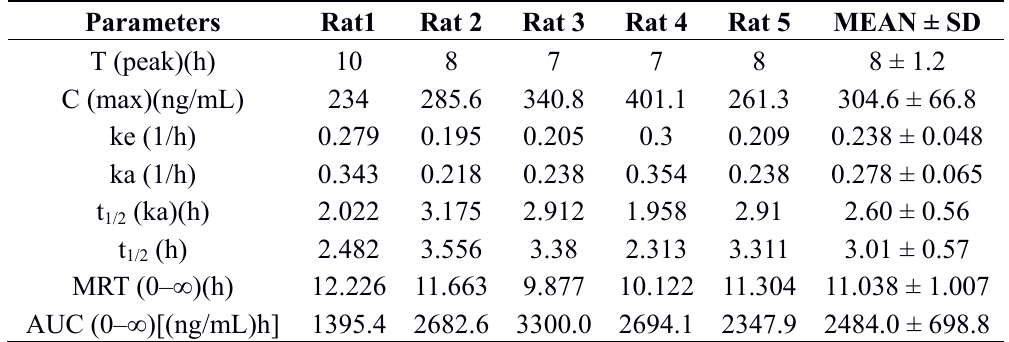
Table 17. Pharmacokinetic parameters of TA-III after intragastrical administration to rats at a dose of 50 mg/kg.